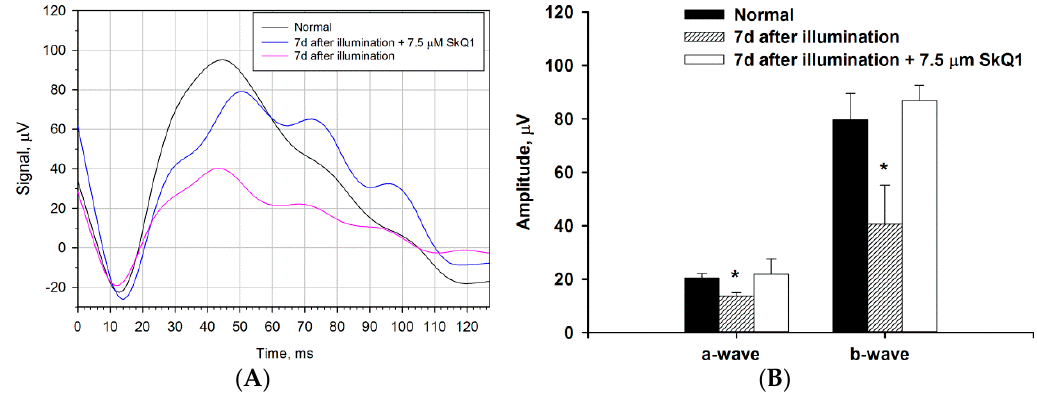
Figure 5. Electrophysiological activity of the rabbit retina under conditions of LIRD with (blue) or without (pink) premedication using SkQ1. The animals were illuminated with intense visible light (30,000 lx) for 3 h. ( A ) Representative scotopic electroretinograms recorded before (black) and 7 days after the illumination. Recordings were made using white flashes at light intensity of 3 cd·s/m 2 . ( B ) Amplitudes of a- and b-waves of scotopic electroretinograms recorded before (normal) and 7 days after the illumination. * p < 0.05 as compared with the respective parameters of the intact retina.